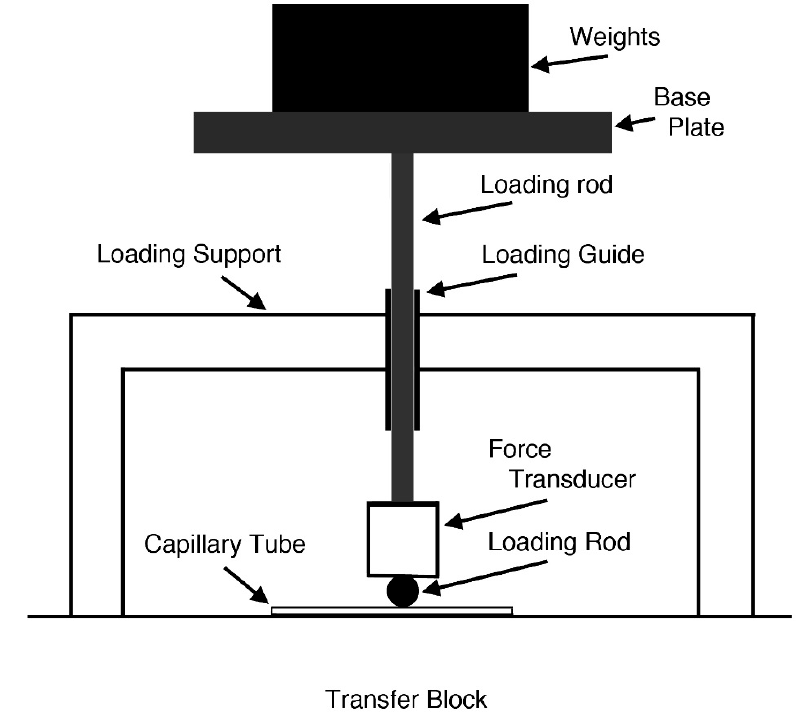
Figure 3. Schematic drawing of a loading device.